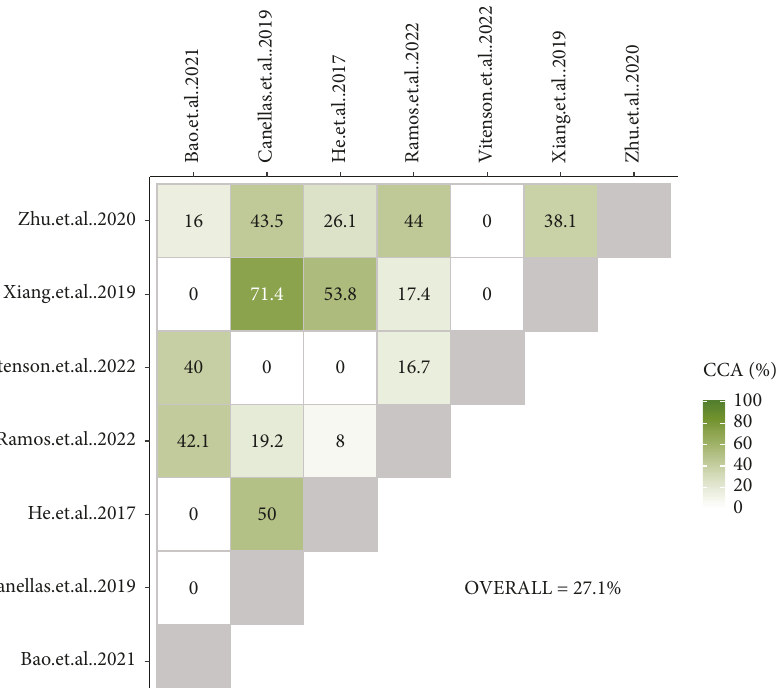
Figure 3: CCA grids of meta-analyses evaluating the effectiveness of PRF application in reducing pain after third molar